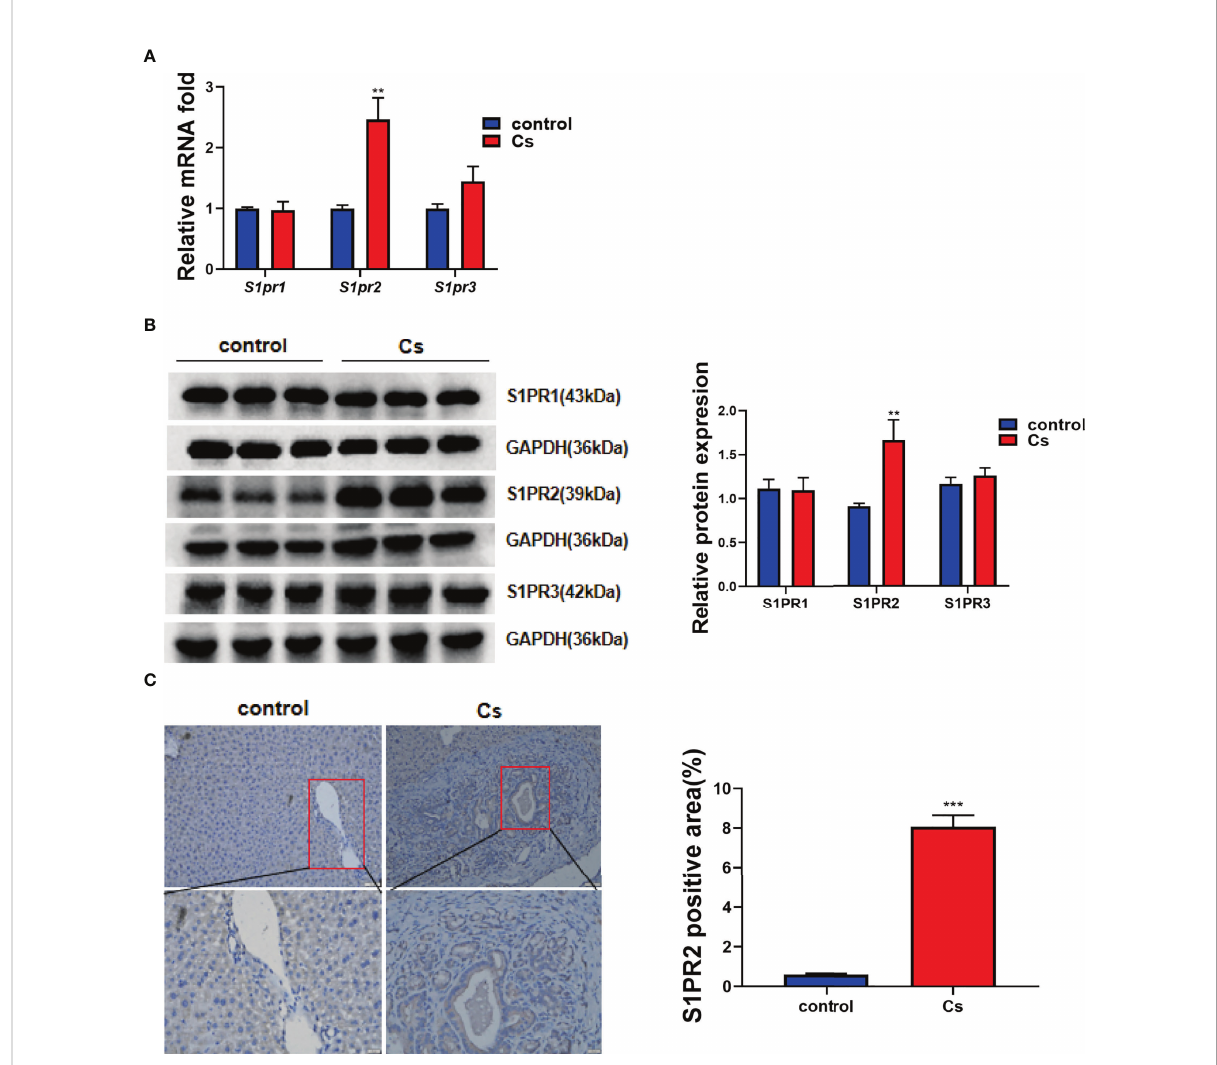
FIGURE 3 C. sinensis infection signi fi cantly increased S1PR2 expression. (A) The relative mRNA expression for S1pr1 , S1pr2 and S1pr3 in hepatobiliary tissue of control and C. sinensis -infected mice. (B) The relative protein expression for S1PR1, S1PR2 and S1PR3 in liver of control and C. sinensis - infected mice. (C) The expression of S1PR2 in liver of control and C. sinensis -infected mice by immuno fl uorescence assay. Compared with control group, ** P <0.01, *** P